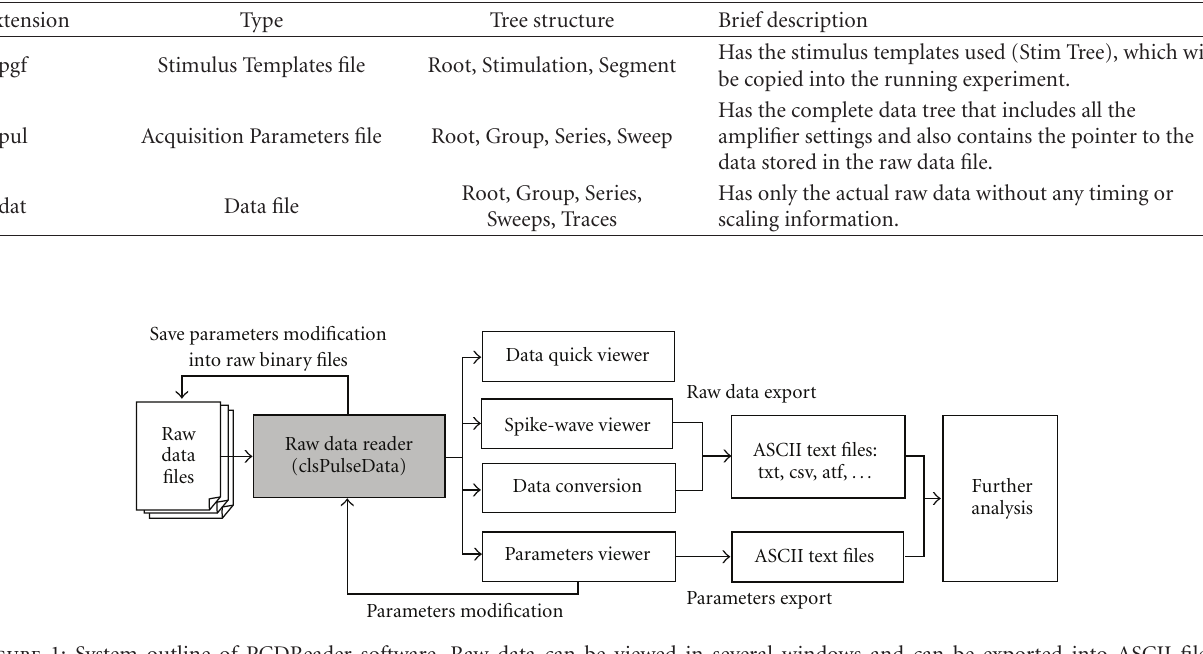
Figure 1: System outline of PCDReader software. Raw data can be viewed in several windows and can be exported into ASCII files. Parameters can be viewed, exported, and modified and modification can be saved back into the binary files.